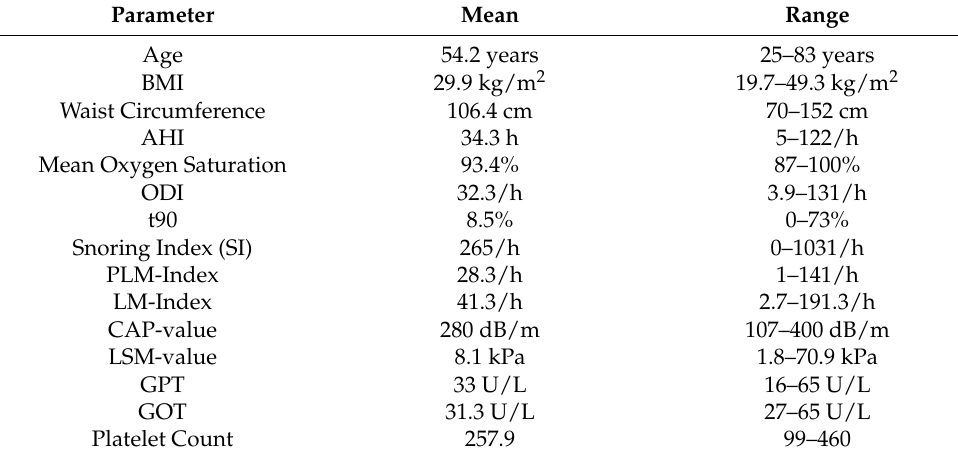
Table 2. Correlation analysis of sleep- and liver-specific parameters using Spearman and